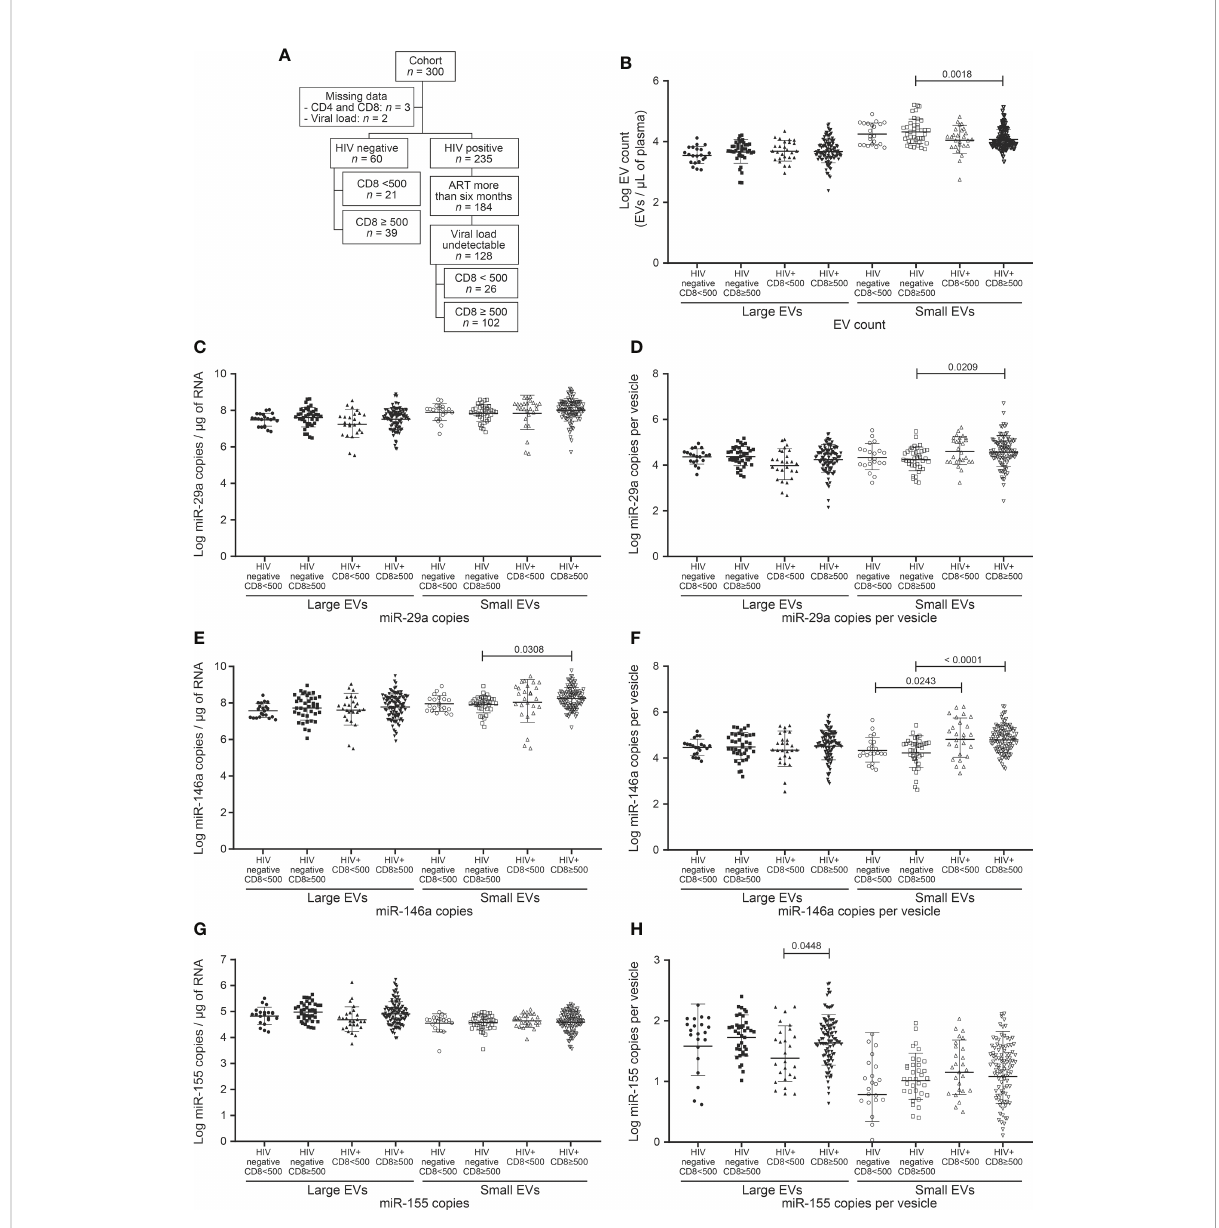
FIGURE 3 EV count and miRNAs expression in study participants following to CD8 T cells count. (A) Flow chart of study participants included in the analysis based on CD8 T cells count. (B) Large and small EVs particles number quanti fi cation in fl ow cytometry analysis. (C, D) , (E, F) , and (G, H) present respectively EVs miR-29a, miR-146a, and miR-155 quanti fi cation and expression as copies per µg of RNA and copies per vesicle. An ordinary one-way ANOVA with Tukey ’ s multiple comparisons test was used for comparison between